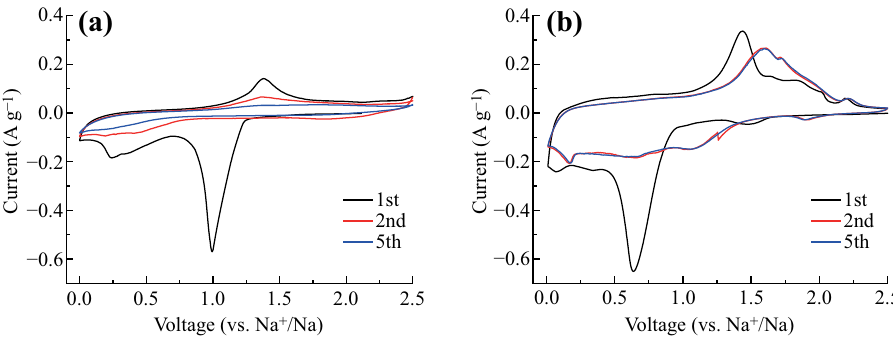
Fig. 4 CV curves of a FeS 2 and b FeS 2 /rGO